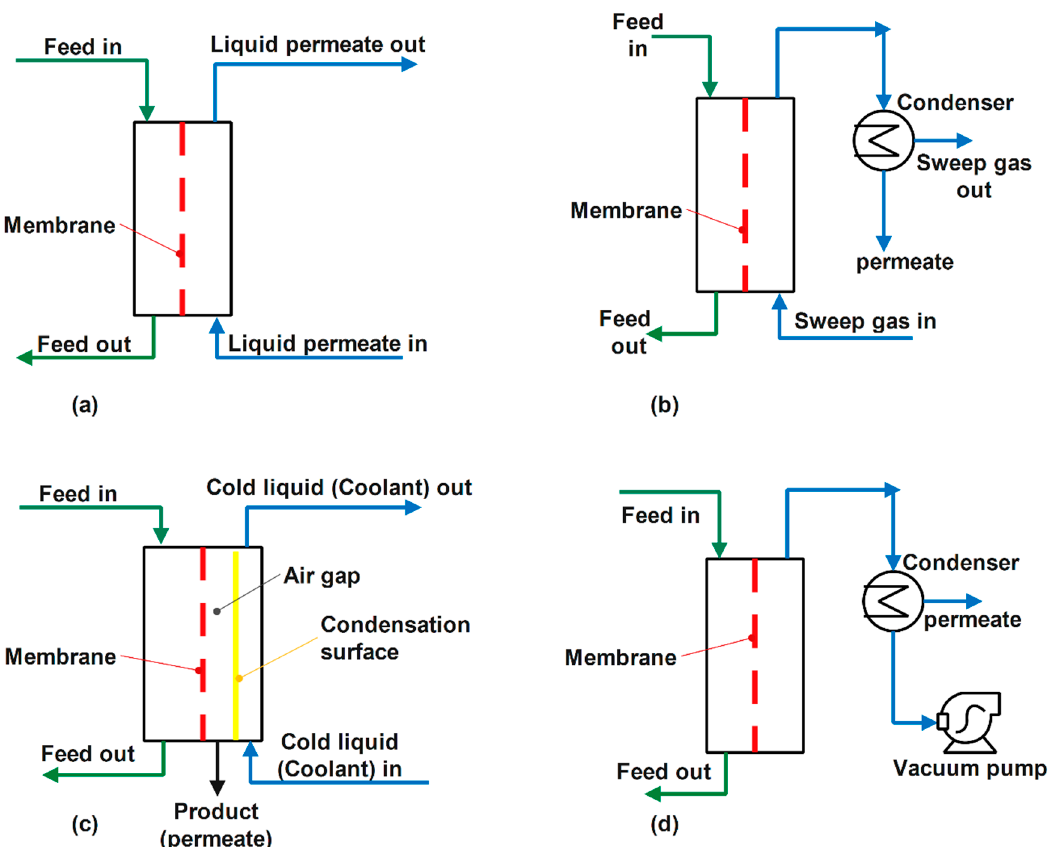
Figure 3. Schematic diagram of conventional membrane configurations ( a ) direct contact membrane distillation (DCMD); ( b ) sweeping gas membrane distillation (SGMD); ( c ) air gap membrane distillation (AGMD); ( d ) vacuum membrane distillation (VMD).